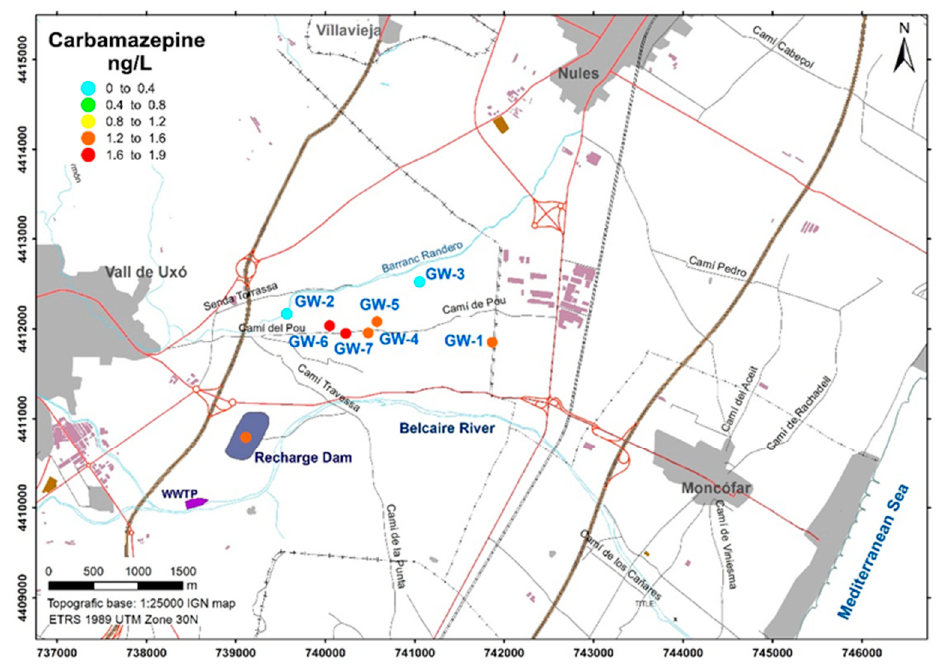
Figure 7. The location map of GW samples and the detected maximum concentrations of carbamazepine.